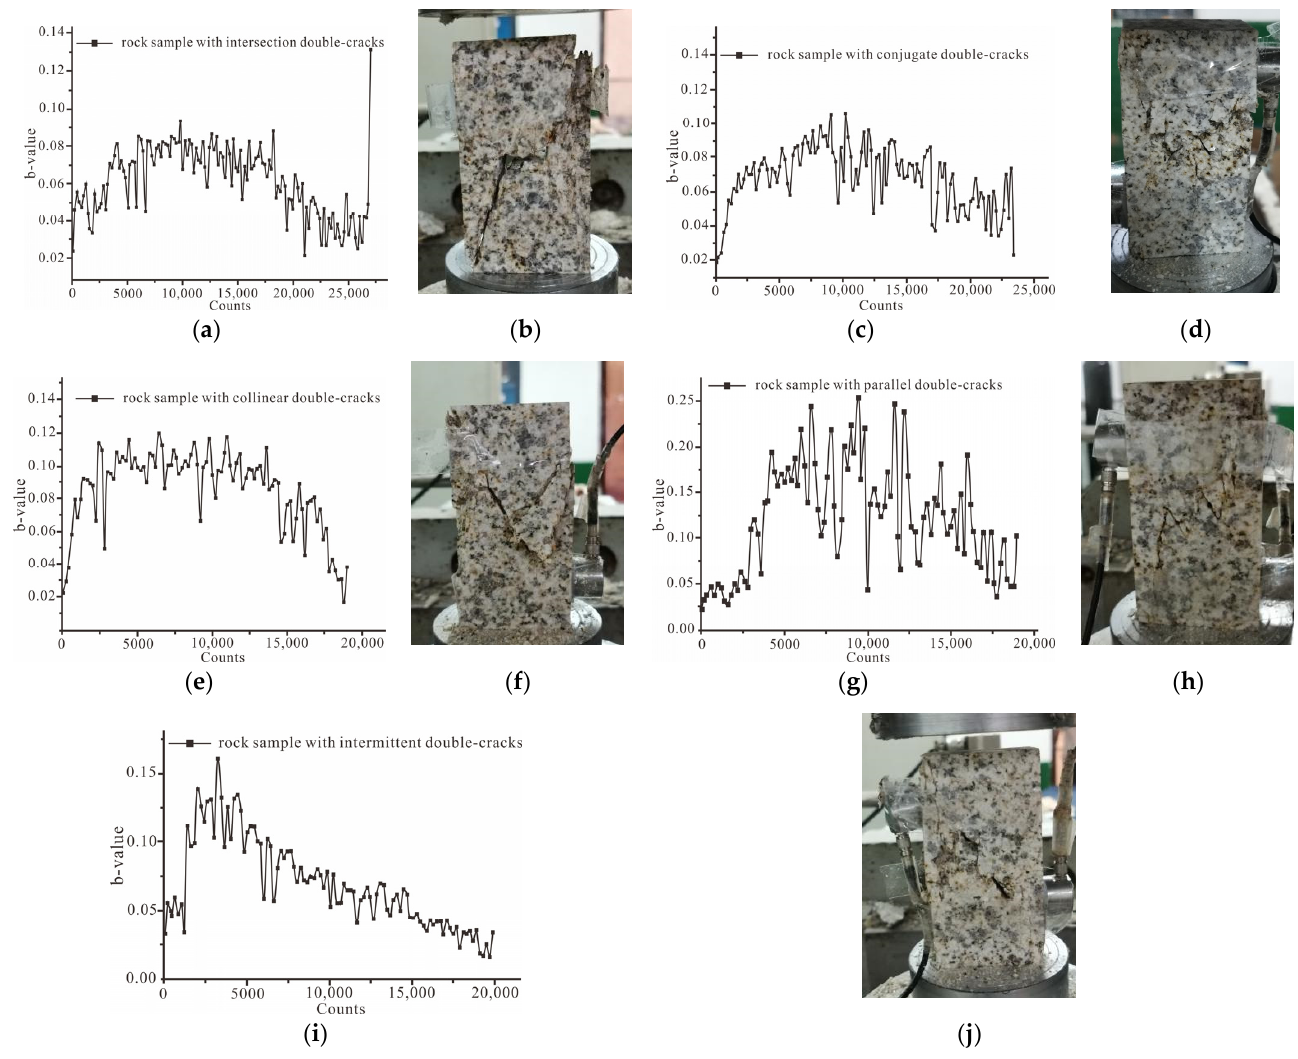
Figure 13. Parameters of the acoustic emission of rock samples with single cracks. ( a ) The curve of the b -value of rock samples with cross double cracks; ( b ) the failure of rock sample with cross double cracks; ( c ) the curve of the b -value of rock samples with conjugate double cracks; ( d ) the failure of rock samples with conjugate double cracks; ( e ) the curve of the b -value for rock samples with collinear double cracks; ( f ) the failure of rock samples with collinear double cracks; ( g ) the curve of the b -value of rock samples with parallel double cracks; ( h ) the failure of rock sample with parallel double cracks; ( i ) the curve of the b -value of rock sample with intermittent double cracks; ( j ) the failure of rock samples with intermittent double cracks.